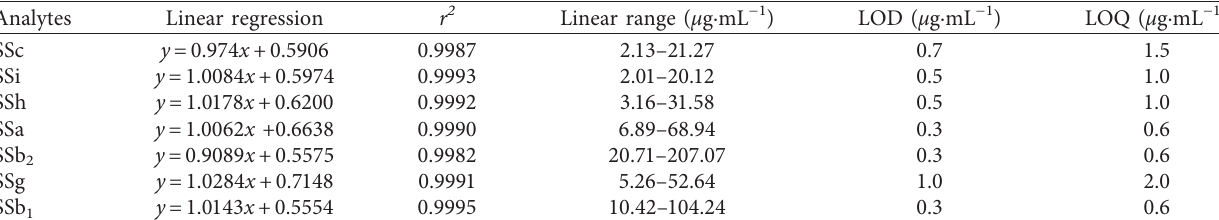
Figure 3: HPLC-CAD chromatograms of seven saikosaponins in XG: blank sample (a), test sample without Bupleuri Radix (b), mixed standard solution (c), and test sample (d). (1) SSc, (2) SSi, (3) SSh, (4) SSa, (5) SSb 2 , (6) SSg, and (7) SSb 1 . Table 2: Linearity, LOD, and LOQ data of 7